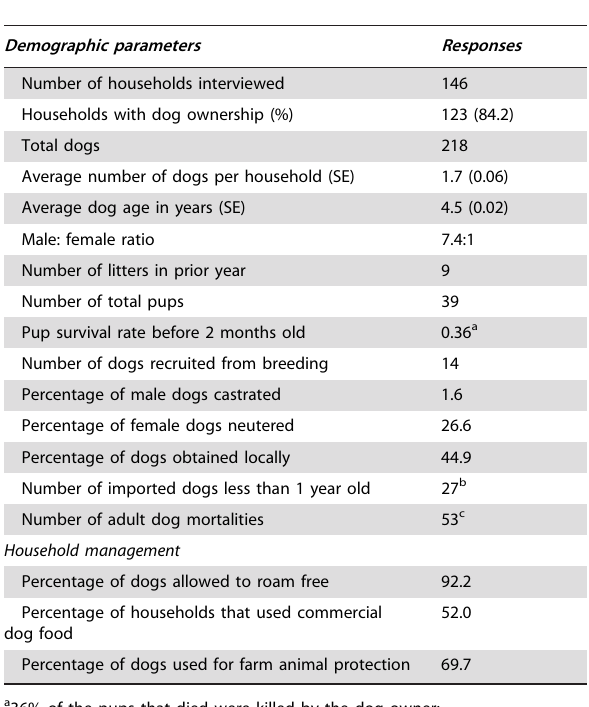
Table 1. Demography and management of rural dogs.